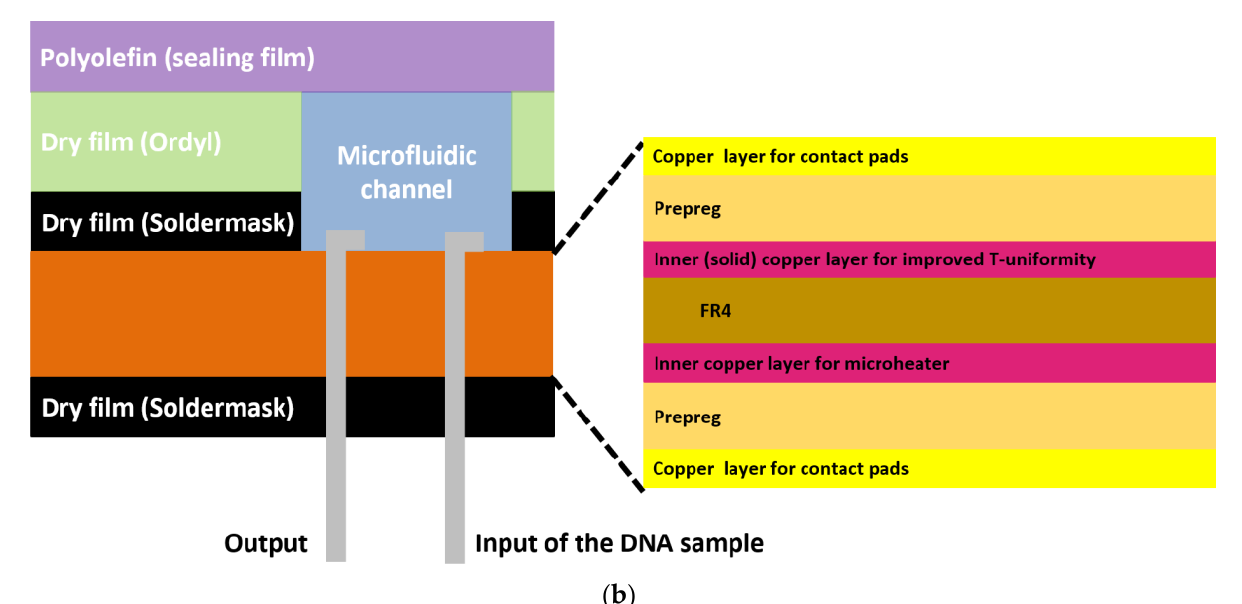
Figure 1. ( a ) RPA-on-PCB chip design for DNA amplification. The meandering microfluidic channel, the microheater with its electrical pads, as well as a solid copper layer beneath the microchannel for optimum temperature uniformity are depicted. ( b ) Schematic cross-sectional view of the RPA-on-PCB chip.